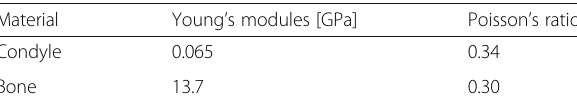
Table 1 Properties of materials used in the finite element